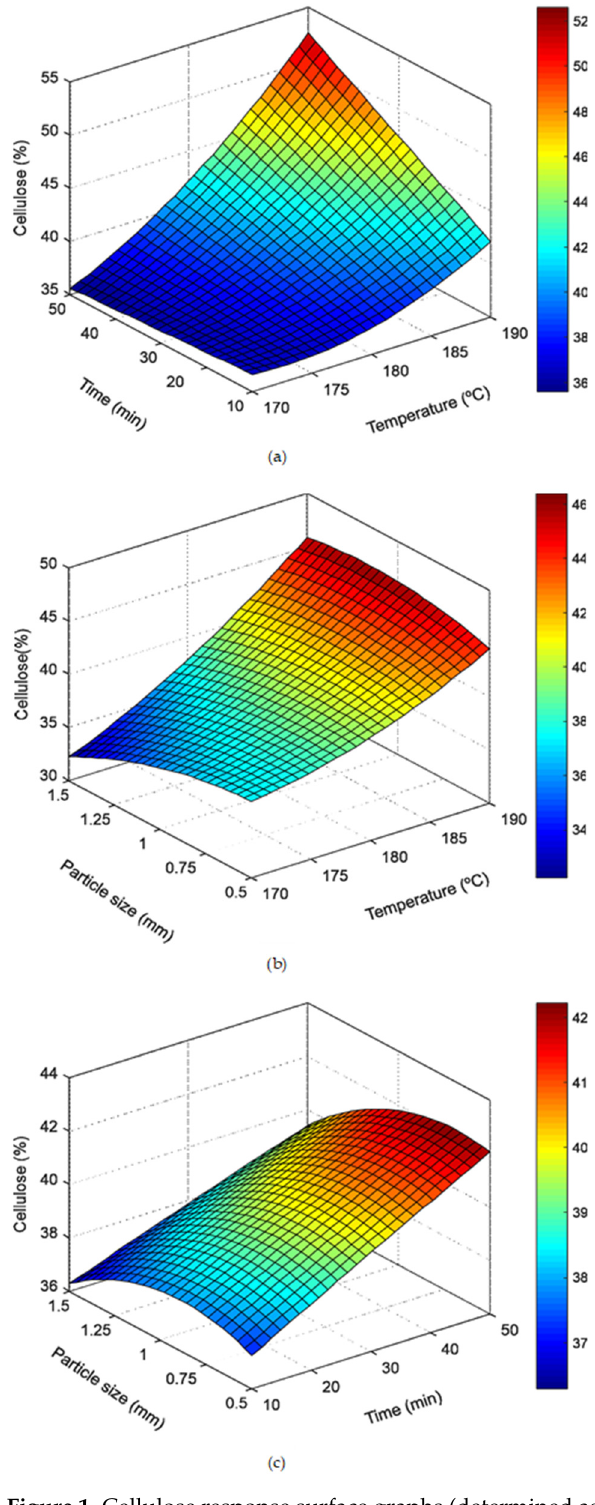
Figure 1. Cellulose response surface graphs (determined as glucan in % of total dry weight) under the operating conditions of the autohydrolysis pretreatment. ( a ) Temperature and time effect on cellulose concentration; ( b ) temperature and particle size effect on cellulose concentration; ( c ) time and particle size effect on cellulose concentration. The higher percentage of cellulose (determined as glucan) and lignin (determined as soluble and insoluble lignin in acid) was obtained under the treatment conditions of the